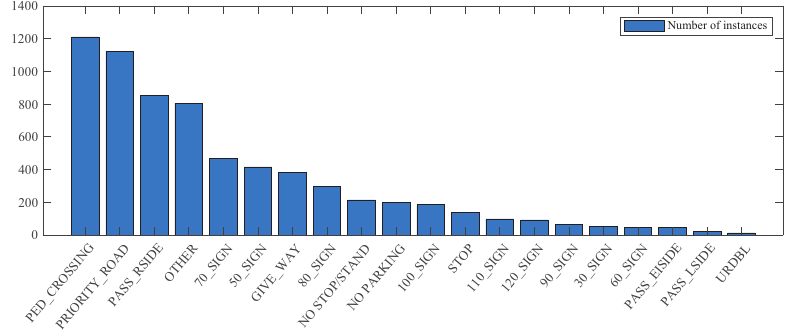
Figure 8. Distribution of instances for the STSD